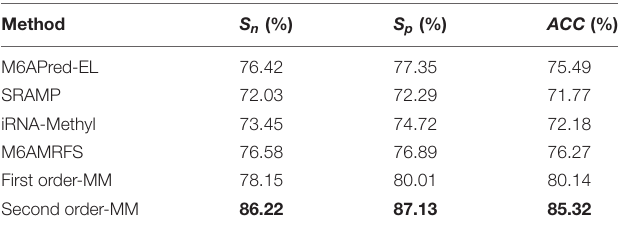
TABLE 3 | Comparison of the prediction effect of m6A in mice based on the m6Avar database. Method